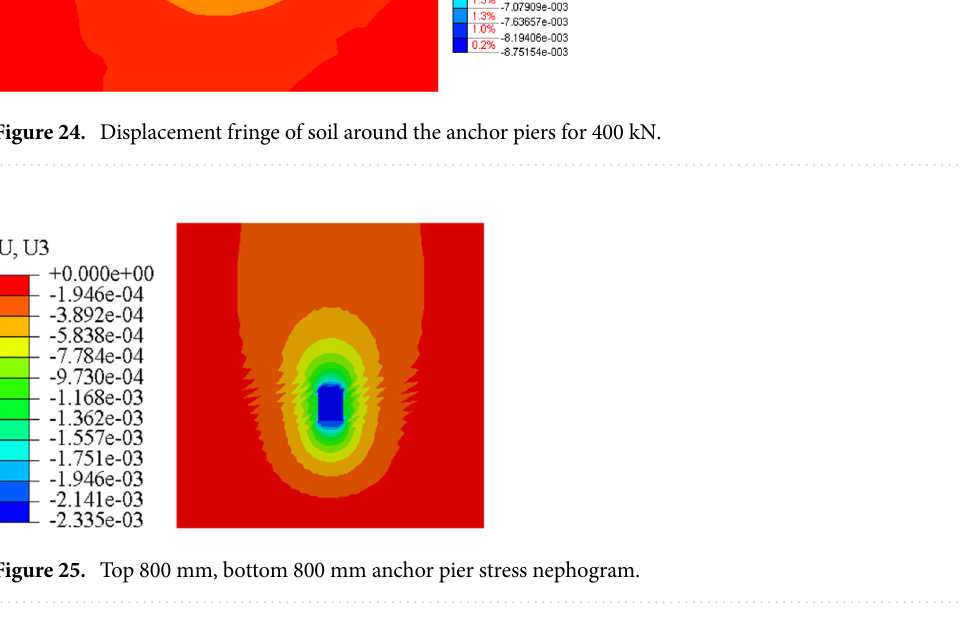
The calculation results. Figure 23 and Fig. 24 are the displacement nephograms of the soil around the anchor piers for 100 kN and 400 kN, respectively. The soil displacement increases with increasing load, the affected area will increase and become uniform, and the area under load will also increase. The soil within the range of 1–3 m around the anchor pier is greatly affected, accounting for 80% of the total force. The soil around the anchor pier should be reinforced, and the anchoring force should be enhanced in the design. In order to further study the influence of anchorage pier size on the displacement and deformation of anchor- age system, finite element models with different sizes are established by finite element method. The stress nepho- gram is shown in Figs. 25, 26 and 27. From Figs. 25, 26 and 27, it can be seen that when the anchor pier is rectangular, the deformation of the tensile anchor system decreases with the increase of the size of the anchor pier, but the degree is small. When